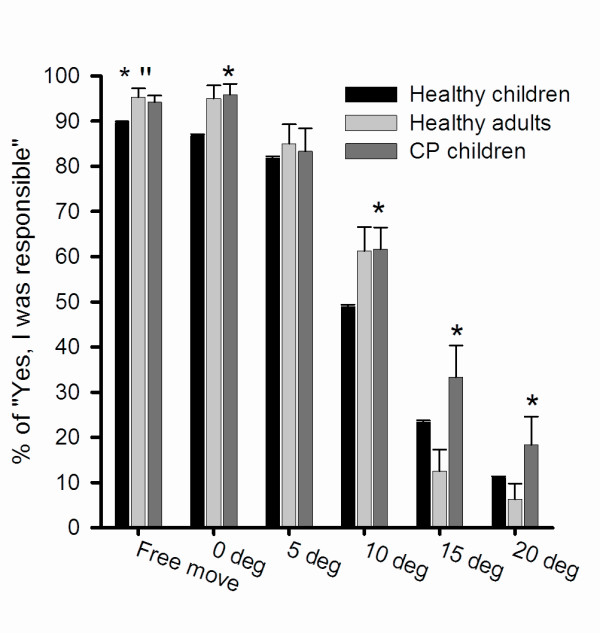
Subjective assessment of agency for the observed movement. The graph displays the percentage of the groups reporting "Yes" according to what the subjects estimated were their responsibility for moving the visual object in the individual movement manipulations. The * indicates the significant difference between the CP children and either one or both of the healthy groups (p < 0.05) and the '' indicates as significant difference between the two healthy groups (p = 0.05).